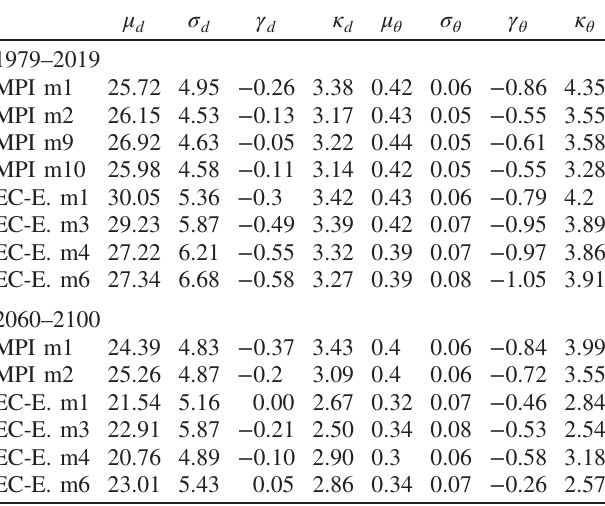
TABLE I. First four moments of the distributions of local dimensions and persistence. μ , σ , γ , κ are the mean, standard deviation, skewness, and kurtosis of the different histograms, respectively. The subscript d or θ indicates whether the analysis focuses on local dimension or persistence. Note that skewness and kurtosis for a normal distribution equal 0 and 3, respectively. “ MPI m i ” or “ EC-E. m i ” indicates the i th member of the respective model